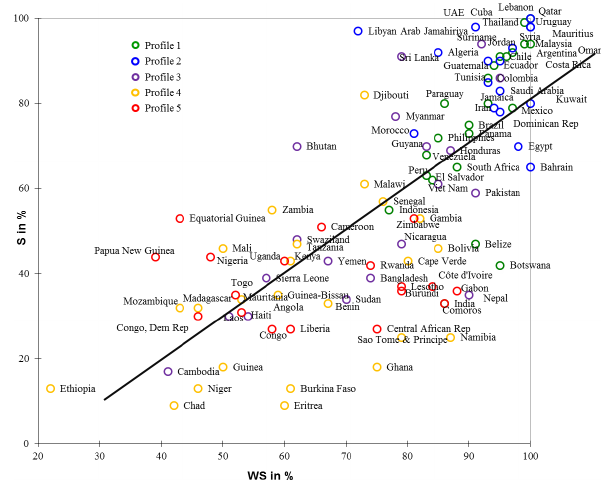
Fig. 7. WS versus S according to 5 country profiles with linear equa- tion as S = 1 . 0285WS − 21 . 82 and R 2 = 0 .